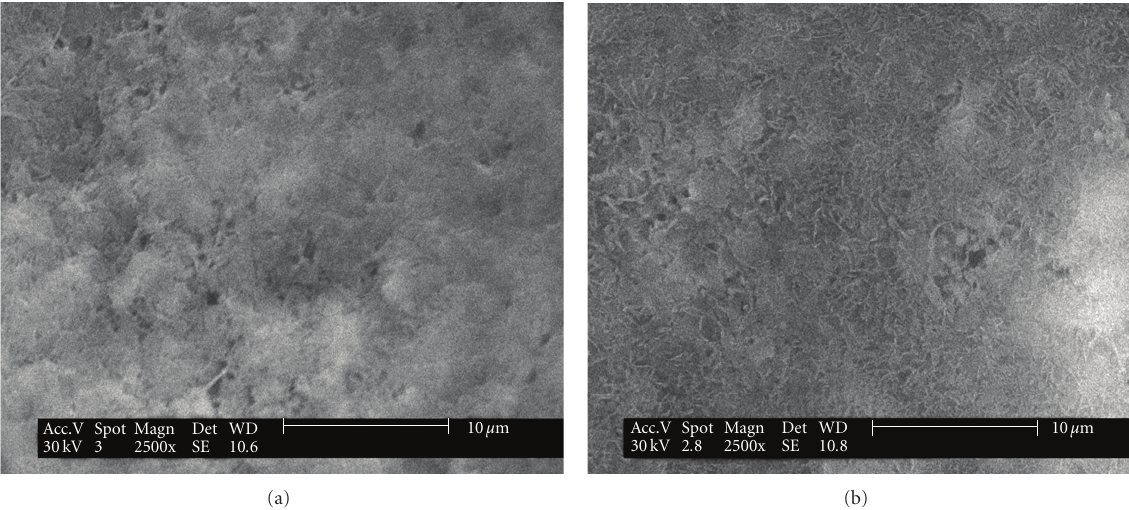
Figure 6: SEM images of samples cured in (a) at low temperature (25 ◦ C for 21 days) and (b) autoclave (180 ◦ C, 12atm for 10 hours).